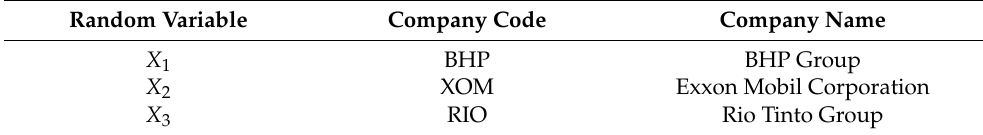
Table 1. Stock return data